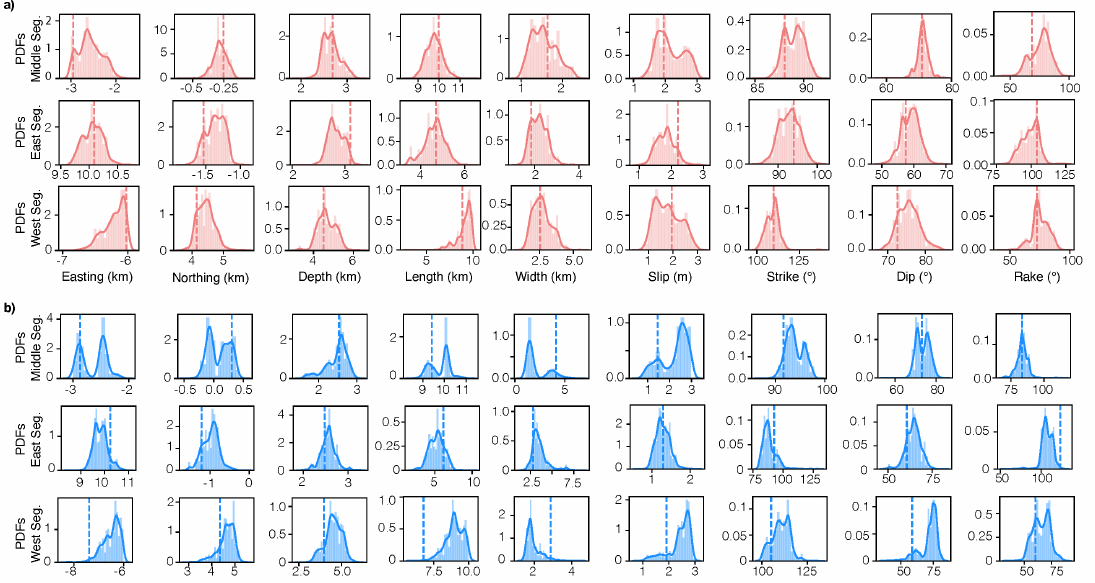
Figure 8. Summary of the posterior PDFs for the optimisation of the three rectangular faults (middle, east, west) in agreement with the co-seismic surface displacements of 2009 earthquake ( a ) and with a stack of co-seismic interferograms of 2009 earthquake ( b ). Dashed vertical lines are best-fitting